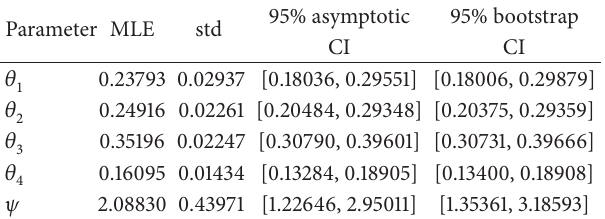
Table 8: MLEs and 95 % confidence intervals of 𝜃 and 𝜓 . Table 9: Posterior modes and estimates of parameters for the cervical cancer